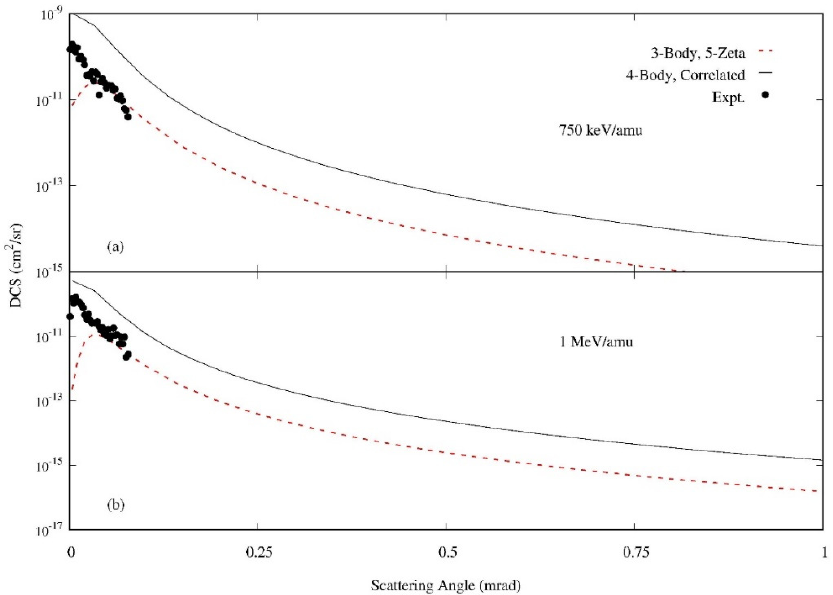
Figure 6. Di ff erential cross sections for B 5 + + He single electron capture to the ground state with the residual He + ion also in the ground state. Experimental results are from [43]. Incident projectile energies are ( a ) 750 keV/amu and ( b ) 1 MeV/amu. In all cases, the captured electron is known to be in the ground state.